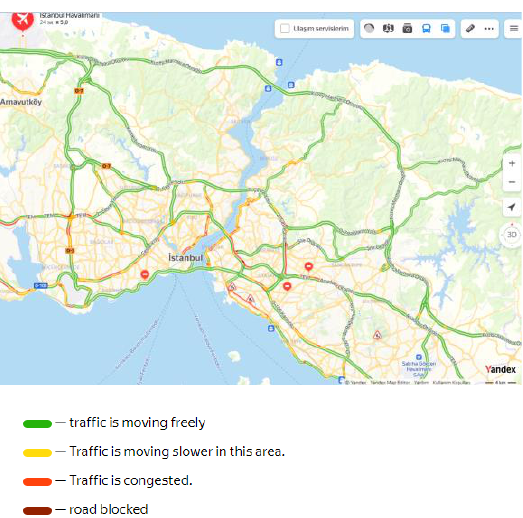
Figure 10. Yandex Maps Istanbul traffic density map and the traffic level is indicated by color.